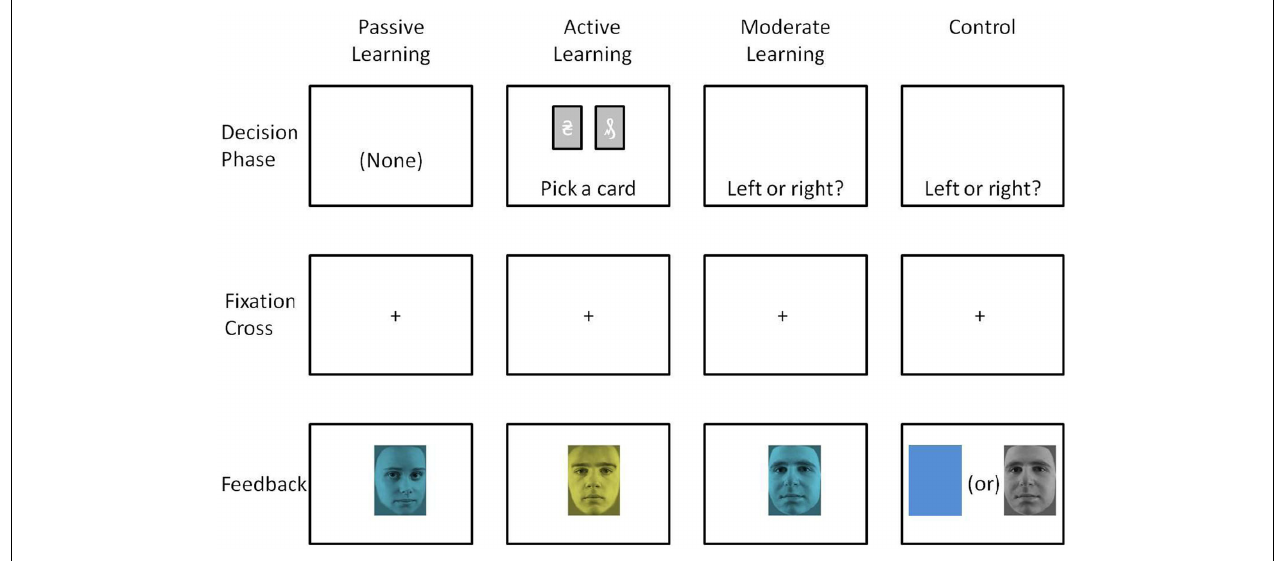
FIGURE 1 | Graphic representation of the four experiments.